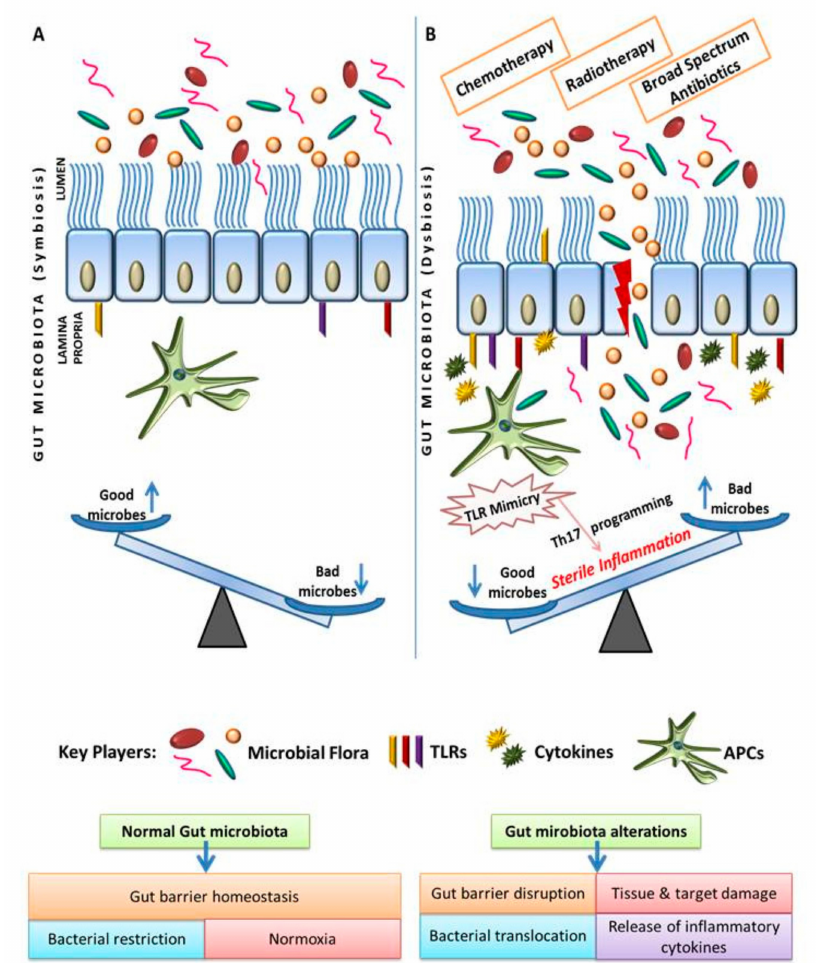
Figure 1. Disruption of normal gut tissue micromilieu including intestinal villi and gut epithelium ( A ) during dysbiosis ( B ) perturb gut immune homeostasis and GI colony index, which is manifested by TLR mimicry, Th17 programming, and hypoxia, which sensitizes normalized gut tissue micromilieu (A) for the progression of gastric inflammatory and tumor